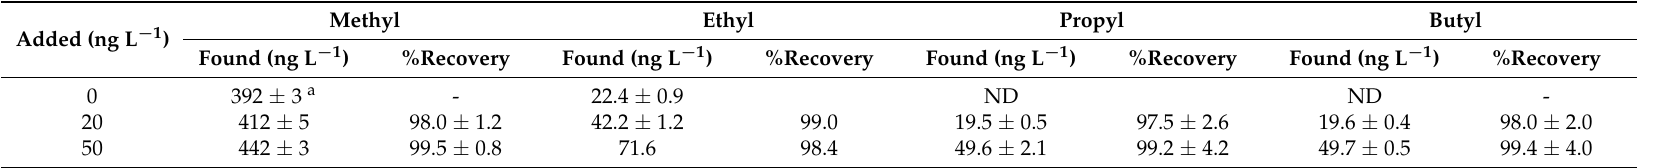
Table 7. Validation of in-syringe MSPE for microextraction of parabens in spiked samples ( n =